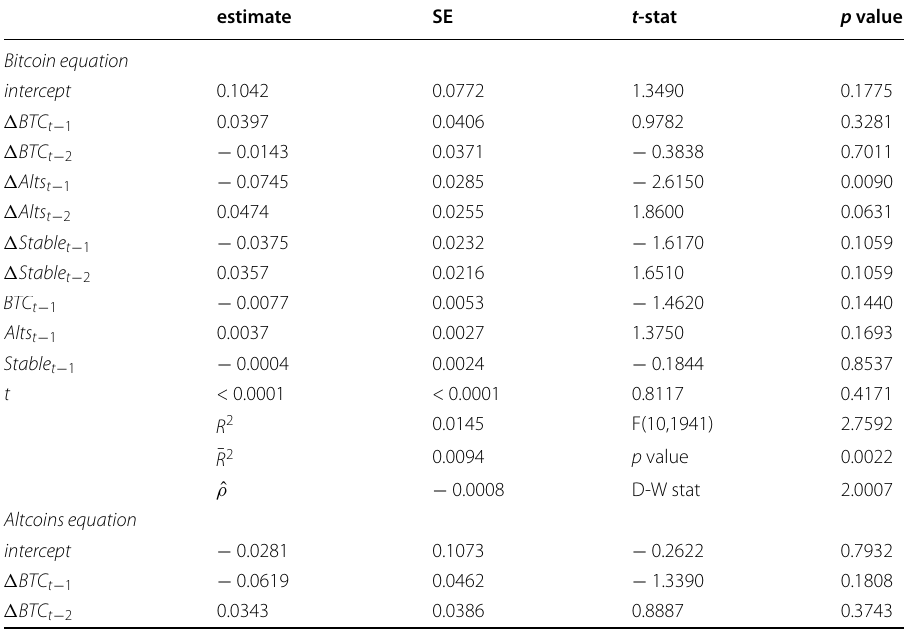
Table 6 Estimated vector error-correction model in the VAR representation (on logarithmic market